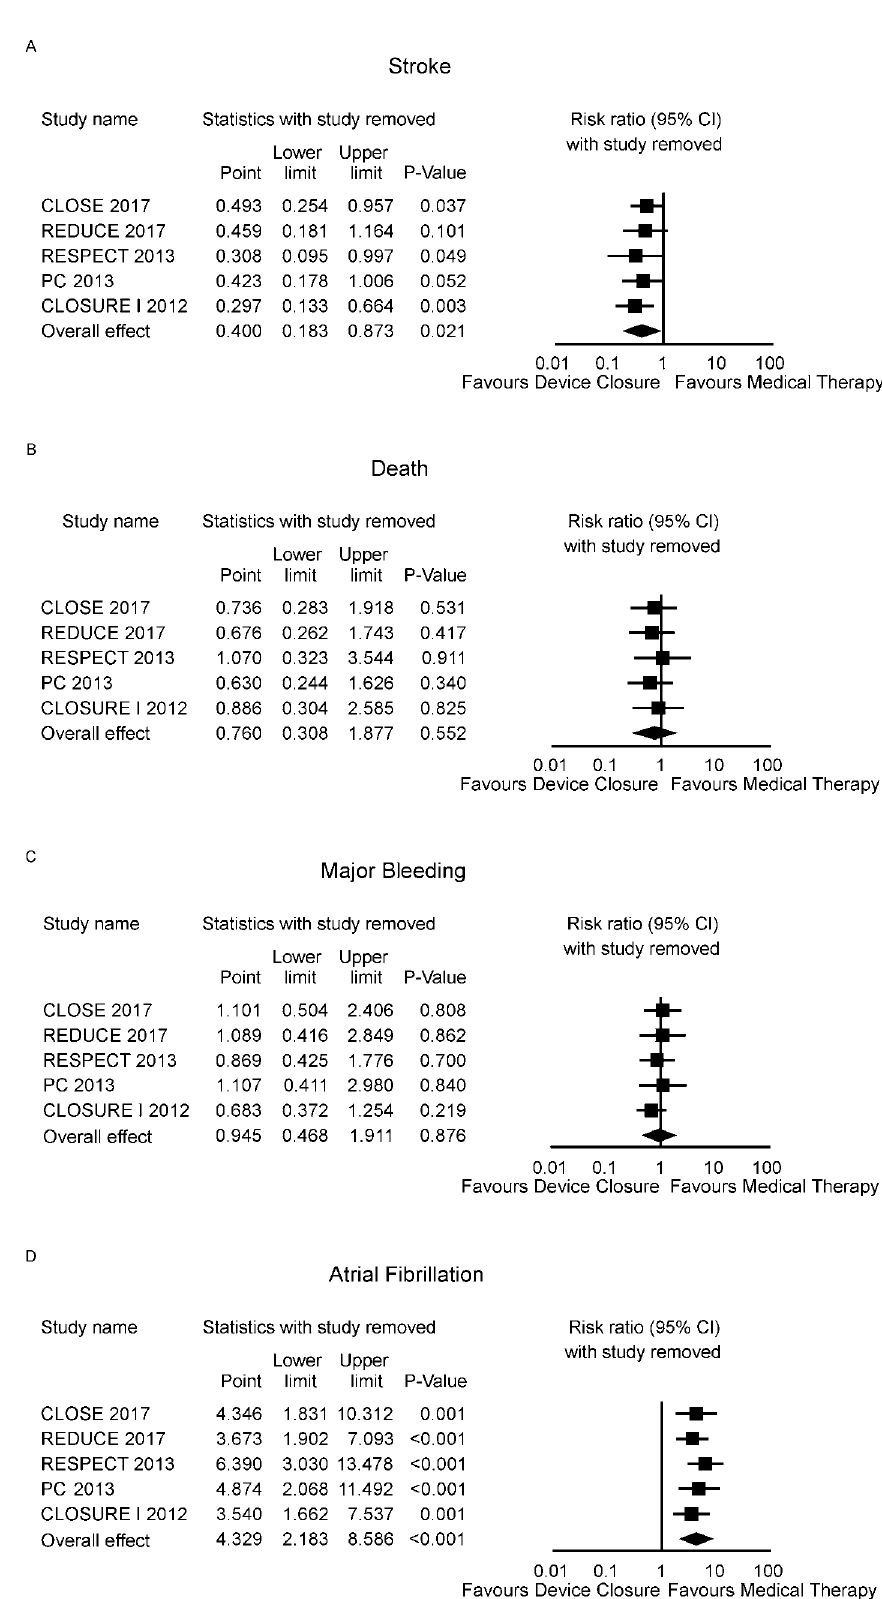
Fig. 5 – Sensitivity analysis – one study